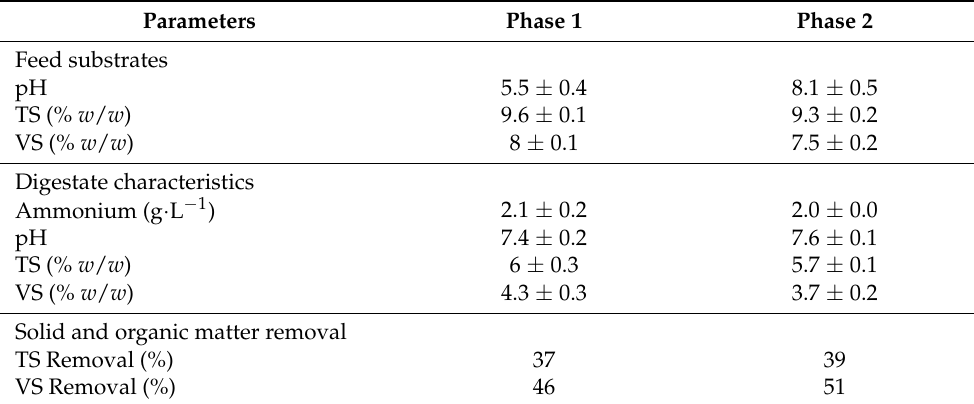
Table 1. Steady-state performances of the digesters (mean ± standard deviation) and organic matter removal during Phases 1 and